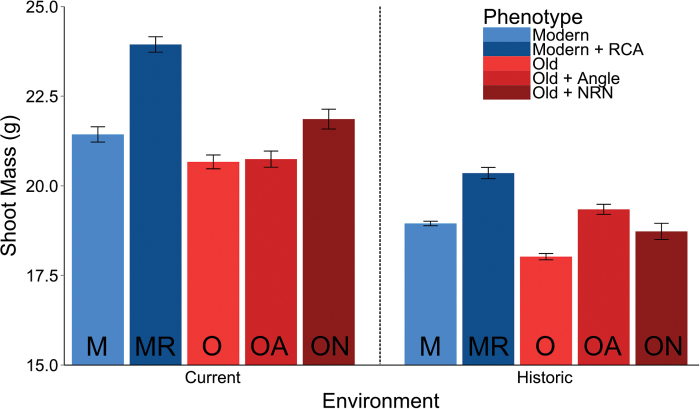
Shoot mass in SimRoot as influenced by density and nitrogen levels and contrasting root phenes in the oldest hybrids relative to the newest. Plants were simulated in very high density (120 000 plants ha–1) and high nitrogen (120K HN), and in low density (40 000 plants ha–1) and low nitrogen (40K LN). Solid bars represent the means, with lines being the standard error. Abbreviations at the bottom of the bar give the phenotype, as follows. The Old (O) phenotype has a steeper angle and a few more nodal roots than the Modern (M) phenotype. Old and Modern have low aerenchyma. Old+Angle (OA) is the same as the Old phenotype but with the same more shallow angle as the Modern, while Old+NRN (ON) is the same as the Old phenotype but with the same fewer nodal roots as the Modern. Modern+RCA (MR) is the Modern phenotype but with high aerenchyma. (This figure is available in colour at JXB online.)